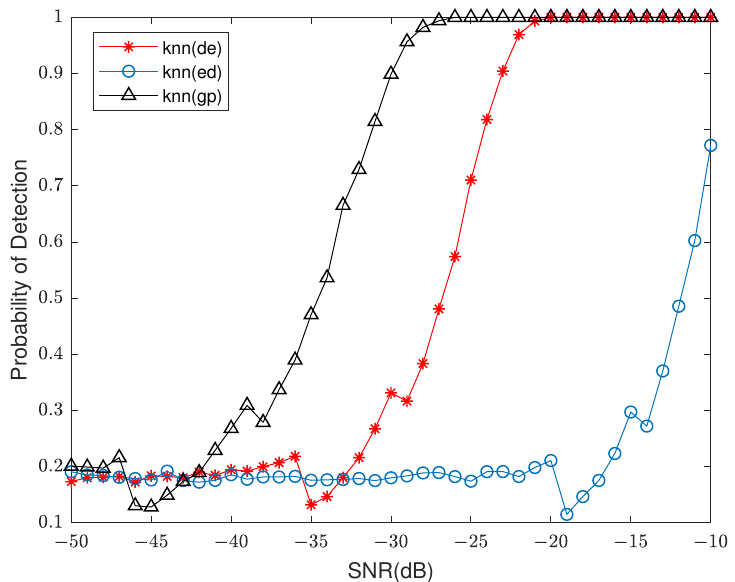
Figure 3. Performance comparison of KNN spectrum sensing methods based on GP, ES and DE. As can be seen from Figure 3, when the SNR is lower than − 23 dB, the detection probability of the KNN spectrum sensing method based on GP features is much higher than that of the KNN spectrum sensing method based on ES features and DE features, and the KNN spectrum sensing method based on GP features can achieve a detection rate close to 1 when the SNR is − 27